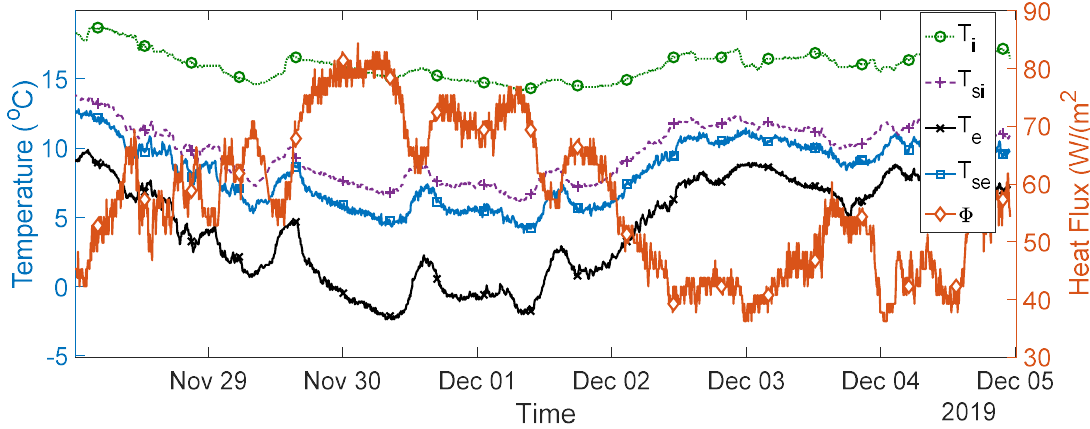
Figure 5. Overall thermal transmission parameter measurement data for 7 days.